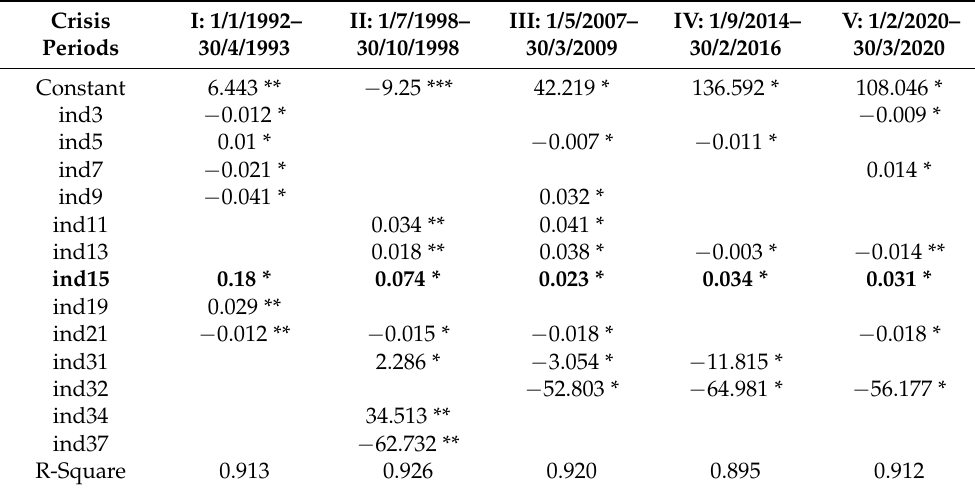
Table 4. Indexes in multiple linear regression models of the Canadian Imperial Bank of Commerce during the 5 crisis